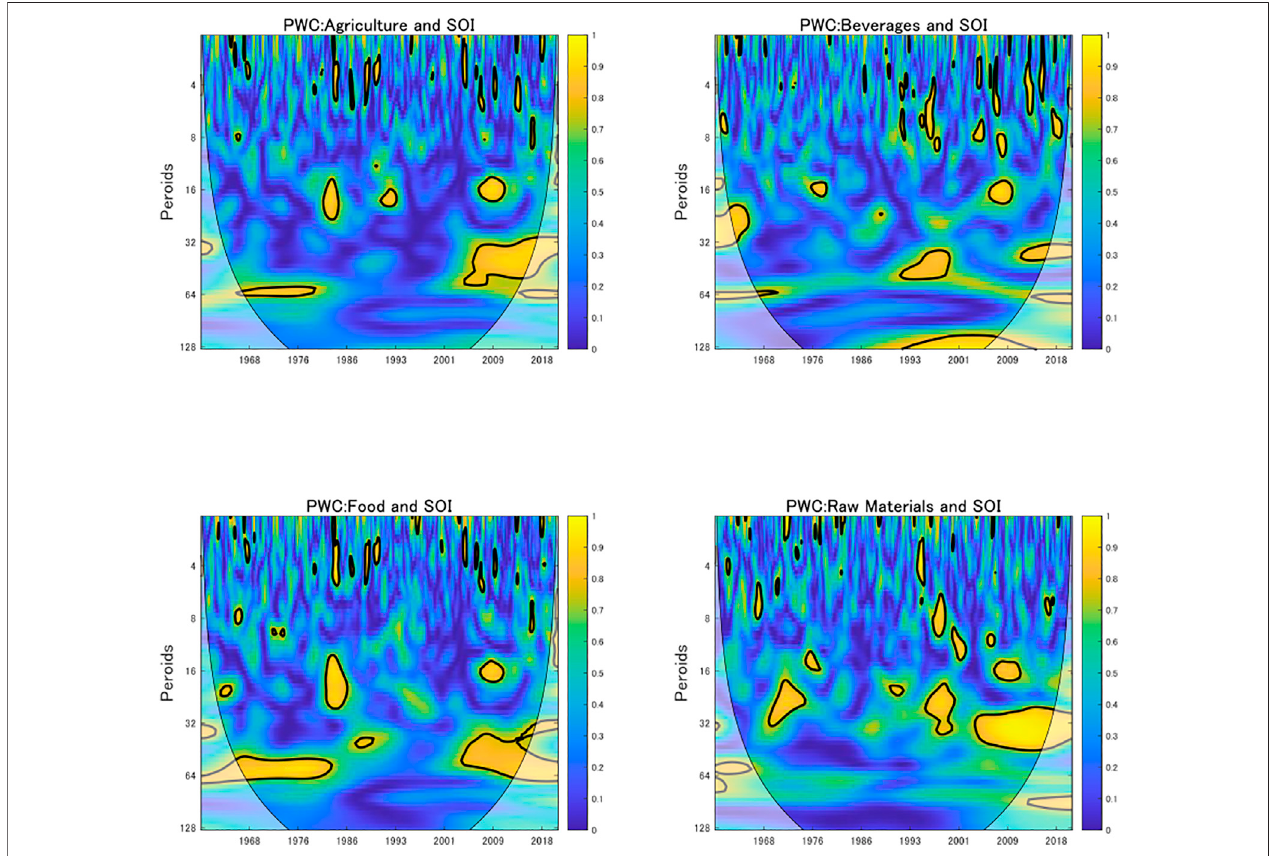
FIGURE 4 | Partial wavelet coherences between commodity prices and SOI. Notes: The black contour shows a 5% signi fi cance level estimated from the Monte Carlo simulations. The color code shows the degree of partial wavelet coherence strength, ranging from blue (low coherence) to yellow (high coherence). The bold lines indicate the edge